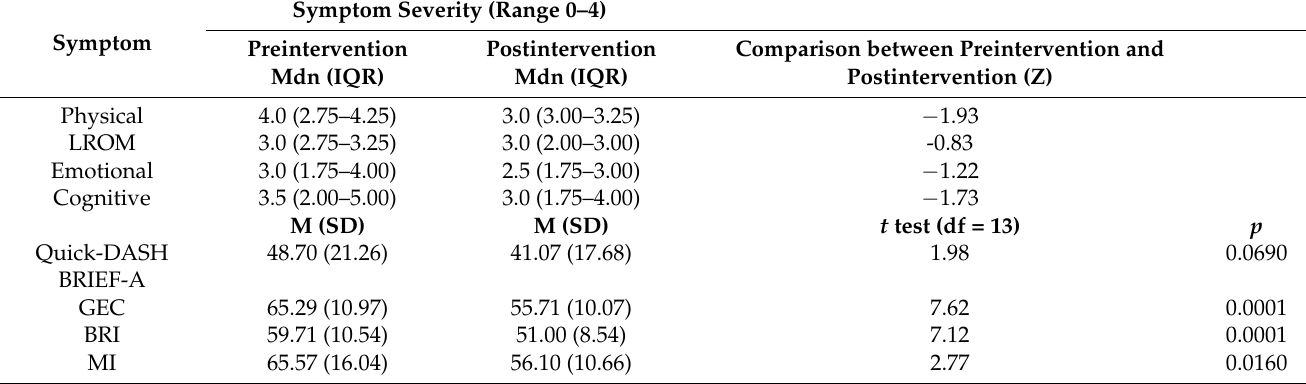
Table 4. Comparisons of self-reported symptoms, upper-extremity function (measured by Quick- DASH), and women’s executive function (by BRIEF-A) between preintervention and postintervention assessments (N =